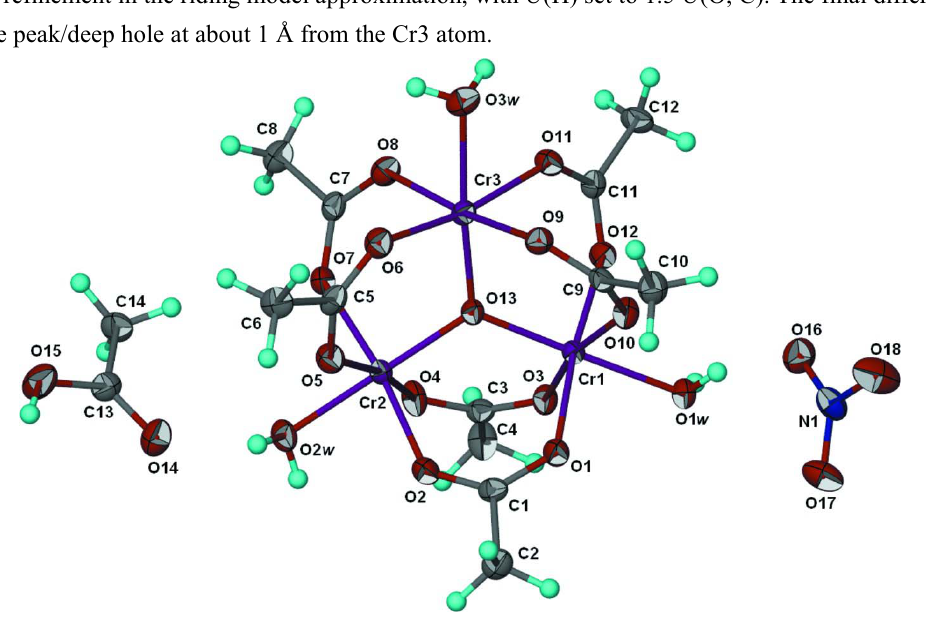
(C H O ) O(H O) ] . [NO ] . CH CO H at the 70% probability level. Hydrogen 3 2 3 2 6 2 3 3 3 2